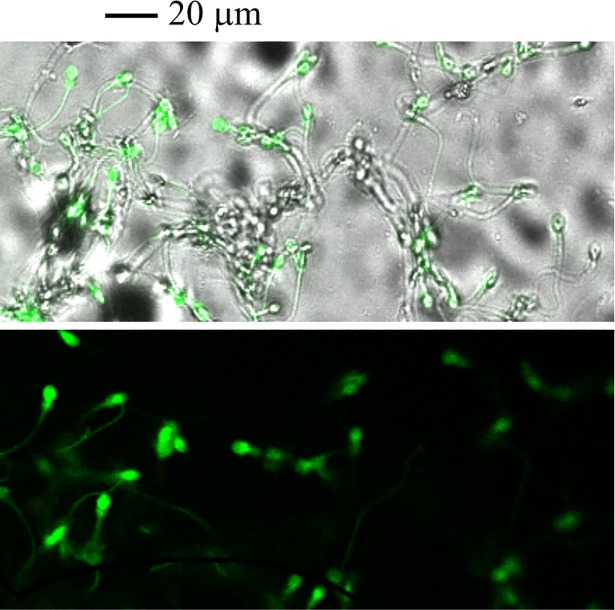
Incorporation of GPL from sub-μm-sized micelles into sperm membranes can be observed with fluorescent GPL crosslinked with Rhodamine 123.Human sperm were incubated with sub-μm-sized micelles made of GPL crosslinked with Rhodamine 123. Images of stained sperm are shown merged with trans-illumination (upper) or in fluorescence mode alone (lower). Note that more than one-half of the sperm are strongly fluorescent.